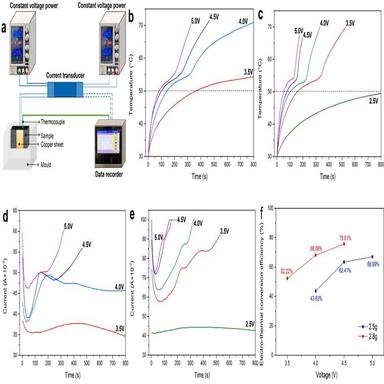
(a) Electro-heat conversion measurement system; Measurements of SA/MMC3 sample with a bulk density of 0.691 g cm− 3 at different constant voltages from 3.5 to 5.0 V: (b) temperature evaluation curves and (c) recorded electrical current curves; Measurements of SA/MMC3 sample with a bulk density of 0.774 g cm− 3 under different constant voltages from 2.5 to 5.0 V: (d) temperature evaluation curves and (e) recorded electrical current curves; (f) Calculated electro-heat conversion efficiencies performing at di